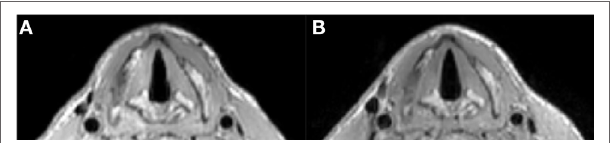
FIgURe 3 | Respiratory triggered T1 TSE sequence (1 mm isotropic voxel size) with parameters as in Table 1 . (A) Shows an image at the level of the vocal cords made with the two loops setup (as in Figure 1A ) and at the maximum acceleration factor of 2.0: total scan time 234 s. (B) Shows an image at the same level made with the dedicated coil and an acceleration factor of 3.0: total scan time 189 s.